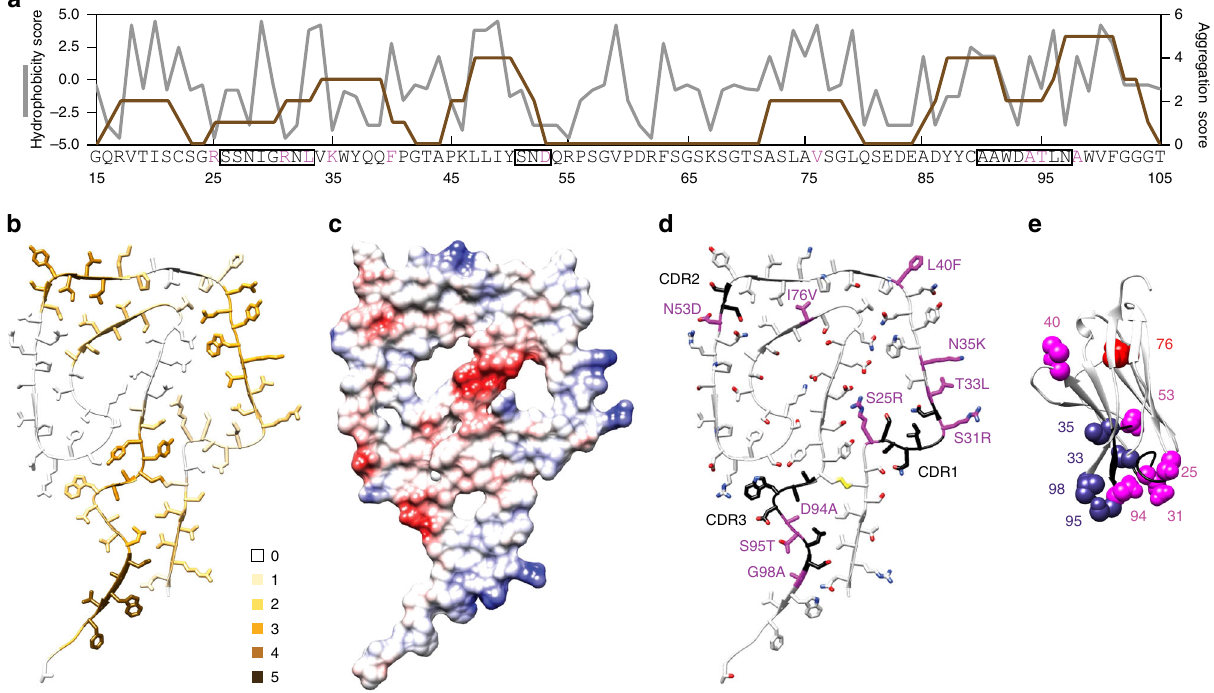
Fig. 3 Location of speci fi c sequence elements in the structure. a Hydrophobicity (gray) and aggregation score (brown) of the ordered part of the fi bril protein. Magenta letters: mutations compared to the IGLV1-44 germ line segment. Boxes: CDRs. Residue numbers refer to the native LC without signal sequence. b Fibril protein showing the residue-speci fi c aggregation score (0 – 5). c Electrostatic surface representation of the fi bril protein. d Fibril protein with CDRs (black) and mutations (magenta) highlighted. e Ribbon diagram of a native V L domain (PDB entry 1BJM) 60 showing residues 3 – 113. CDRs are colored black; mutations are colored in red if they affect the core (residue 76), purple (surface residues with potential relevance for domain – domain interactions), or magenta (other surface